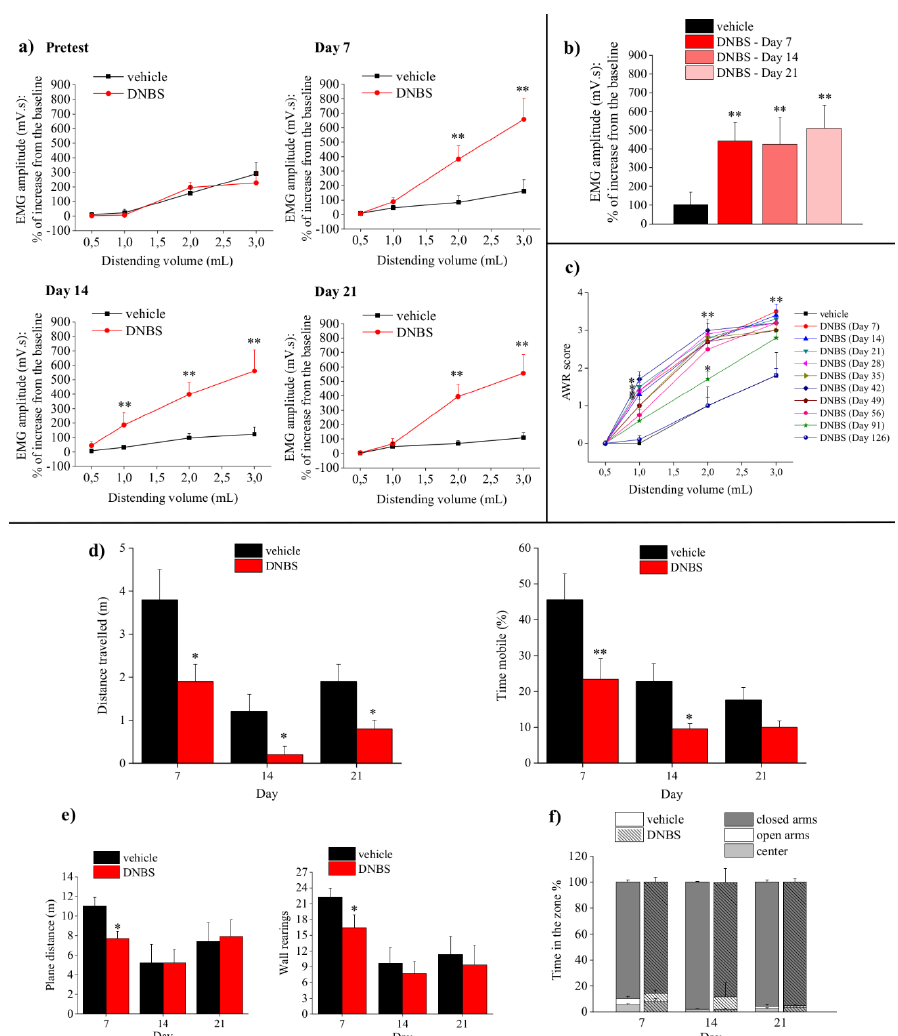
Figure 1. Assessments of visceral hypersensitivity and related behavioral disorders at different time points after DNBS injection. ( a – c ) Assessments of visceral sensitivity. ( a ) Viscero-motor response to colo-rectal distension. ( b ) Viscero-motor response to rectal distension. ( c ) Abdominal withdrawal reflex in response to colo-rectal distension. Each value represents the mean ± SEM of 8 animals per group. * p < 0.05 and ** p < 0.01 vs. vehicle-treated control animals. ( d – f ) Assessments of depressive- and anxiety-related behaviors. ( d ) Forced Swim Test; ( e ) Open Field Test; ( f ) Elevated Plus Maze Test. Each value represents the mean ± SEM of 8 animals per group. * p < 0.05 and ** p < 0.01 vs. vehicle-treated